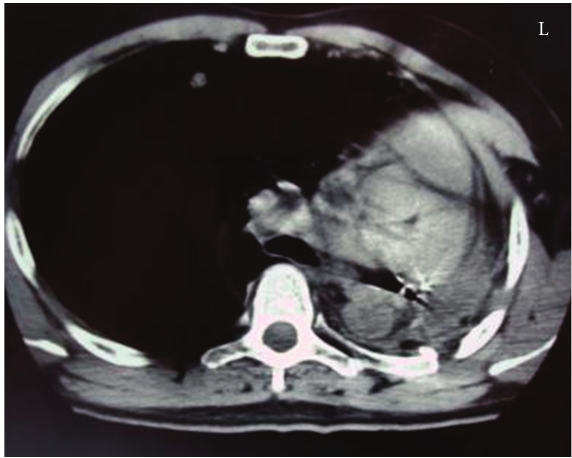
Figure 2: Left pneumectomy; Nodular matastases.